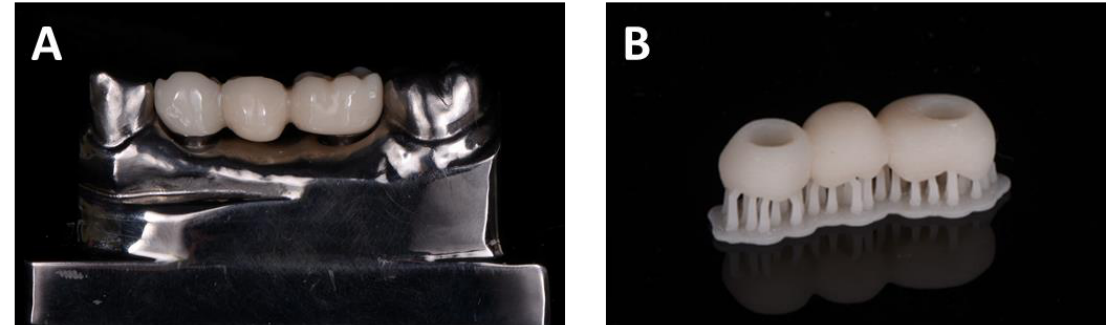
Figure 1. ( A ) Metal master typodont fabricated with Straumann Bone Level Tapered Regular CrossFit ® implant analogs and cementable abutments at mandibular left first premolar and first molar. Self-cured poly(methyl methacrylate) provisional fixed dental prosthesis is placed on metal master typodont. ( B ) 3D-printed resin provisional fixed dental prosthesis with support structures.